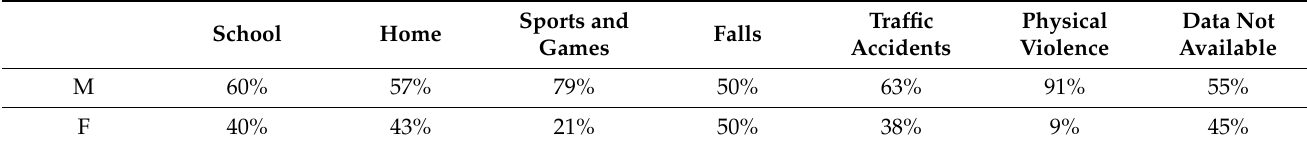
Table 2. Etiology in relation to gender.